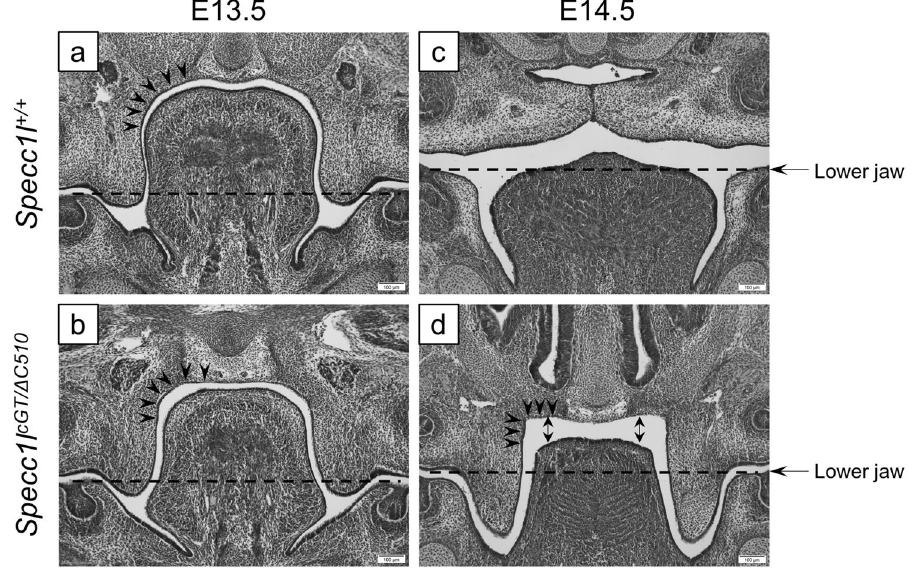
Figure 2. Abnormal Specc1l cGT/ΔC510 mutant palatal shelf morphology at E14.5. ( a – d ) Histological sections from wildtype ( a , c ) and Specc1l cGT/ΔC510 mutant ( b , d ) embryos at E13.5 ( a , b ) and E14.5 ( c , d ) are shown. At E13.5, wildtype palatal shelf presents with a rounded curve around the tongue (( a ), arrowheads). This curvature in the mutant is already more angular at E13.5 (( b ), arrowheads), and becomes much more acute at E14.5 (( d ), arrowheads) during the delayed shelf elevation. The depression of the tongue from E13.5 to E14.5 in the mutant appears adequate when compared to the level of the lower jaw (( a – d ); dashed line). At E14.5 in the mutant,